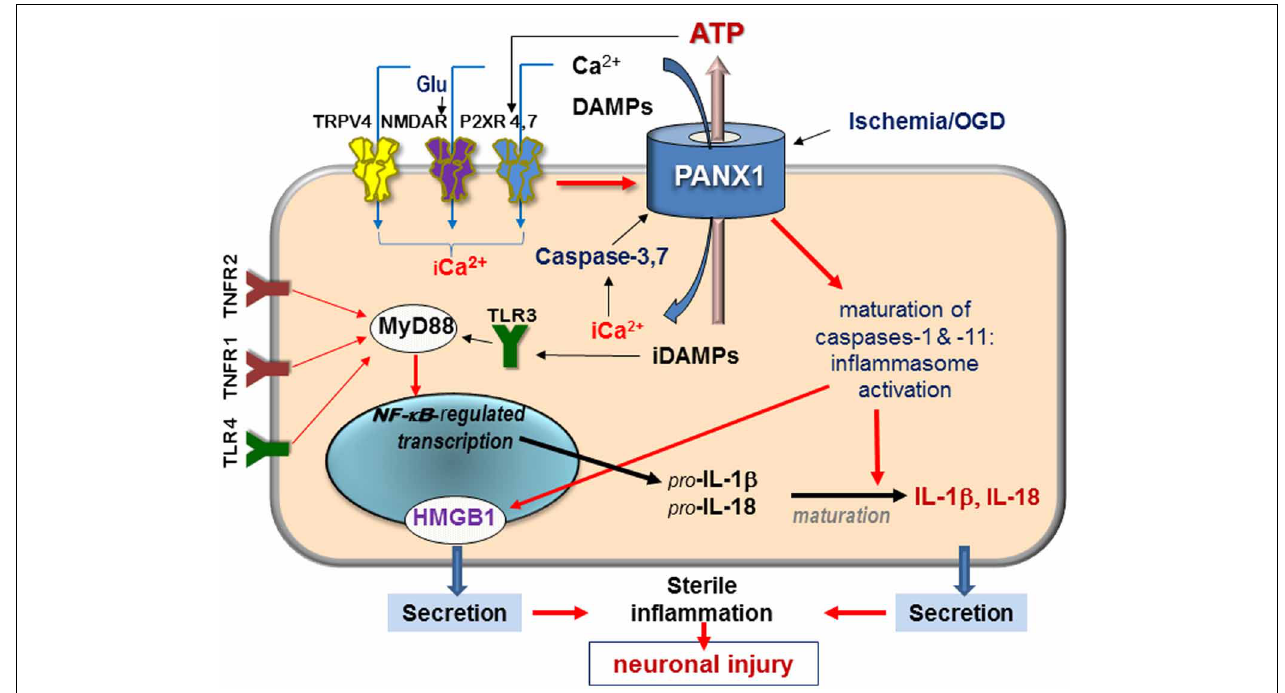
FIGURE 1 | Schematic diagram of signaling mediated by surface receptors and Panx1—in the injured retina in response to ischemia and extracellular danger signals. Abbreviations: Glu, glutamate; DAMPs, danger-associated molecular patterns; iCa 2 + , intercellular free calcium; TRPV,